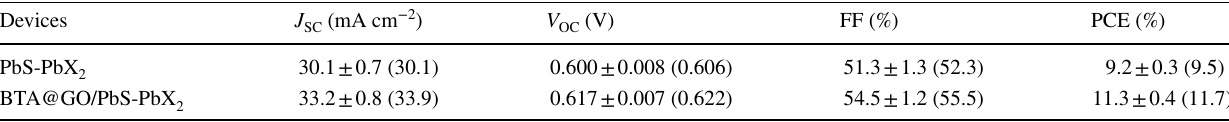
Table 2 Performance parameters of CQDSCs based on PbS-PbX 2 CQDs film and BTA@GO/PbS-PbX 2 hybrid CQDs film. Light intensity for the measurement is one-sun